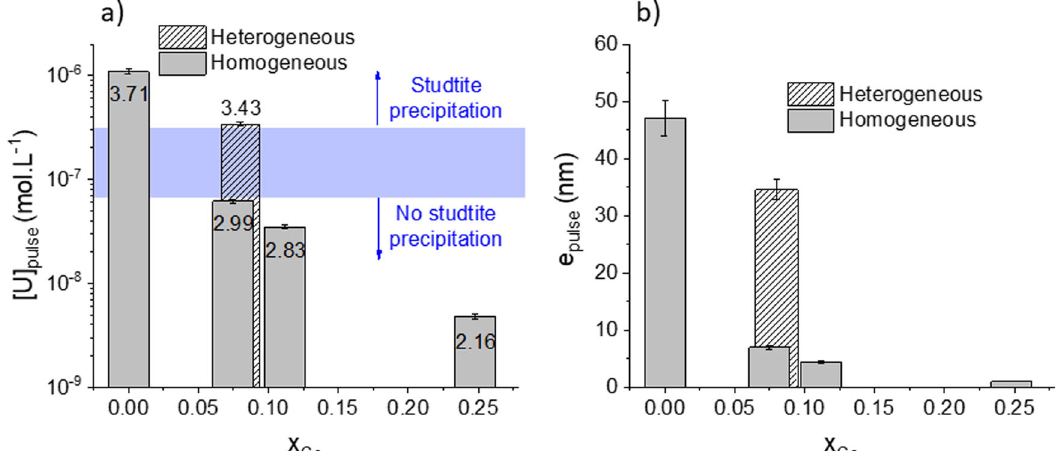
Fig. 9 Comparison of leaching experiments. a Elemental uranium concentration in the leachate as a function of the Ce content during the initial pulse – Saturation index with respect to studtite is indicated for each case. The dotted blue lines indicate the presence (upper line) and the absence (bottom line) of metastudtite observation at the samples surface. b Total alteration thickness at the end of the pulse (t = 50 h) as a function of the Ce content. Error bars are twice the standard